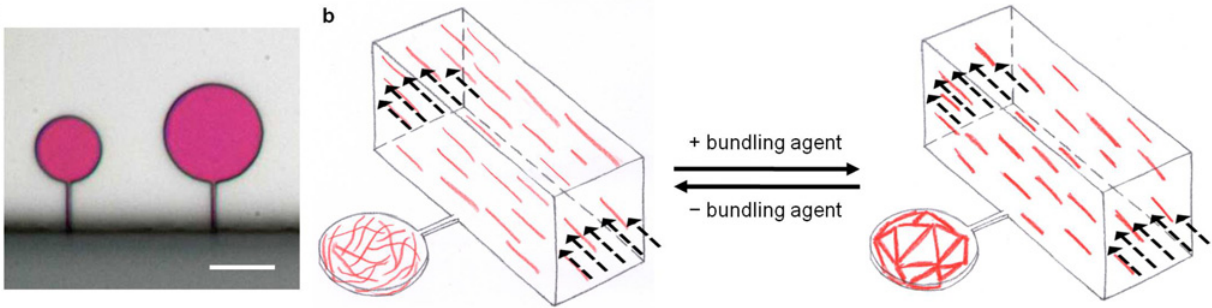
Fig 1. The microfluidic set-up and the schematic experimental plan. (a) Zoomed-in view of a silicon wafer master showing a circular microchamber. The quasi two-dimensional ( h = 0.5 μ m) microchamber is attached to the controlling channel ( h = 5.5 μ m) via a narrow connecting channel (0.5 μ m wide). The scale bar represents 10 μ m. (b) In a step-by-step reaction sequence, the addition of bundling agents to a steady-state of actin filaments induces the bundling reaction resulting in a network of actin bundles while their subsequent depletion brings back the system to the original state of entangled filaments, in a diffusion-controlled